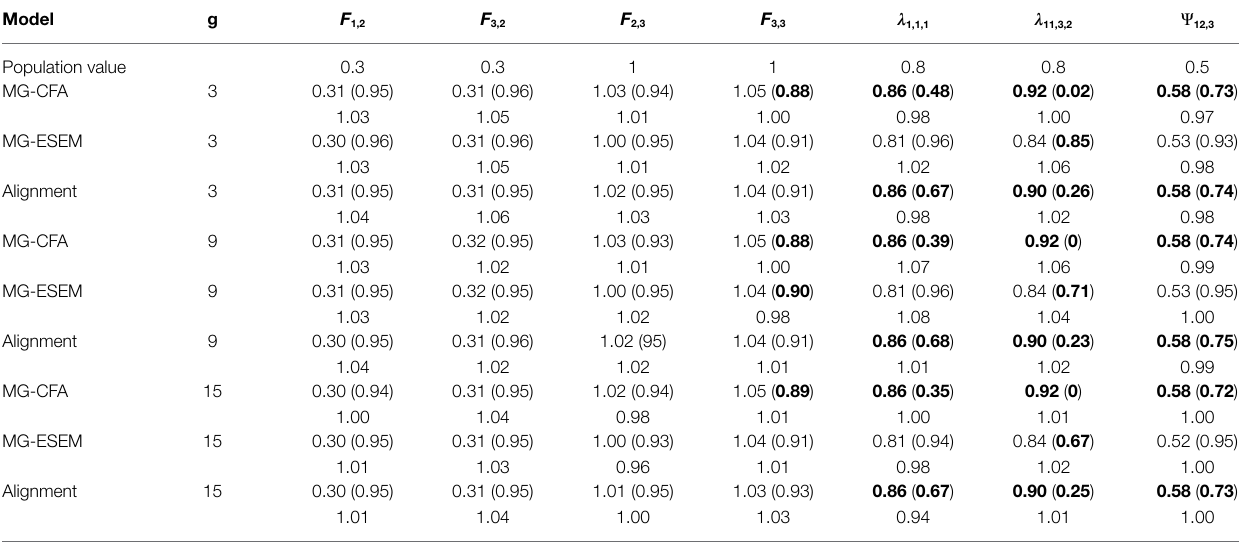
The values inside parentheses are coverage rates, the values on the left side of the parentheses are parameter estimates, the values under the parameter estimates and coverage rates are ratios of average standard error to standard deviation. The values in bold do not meet the four standards which determine the accuracy of parameter estimates proposed in research design